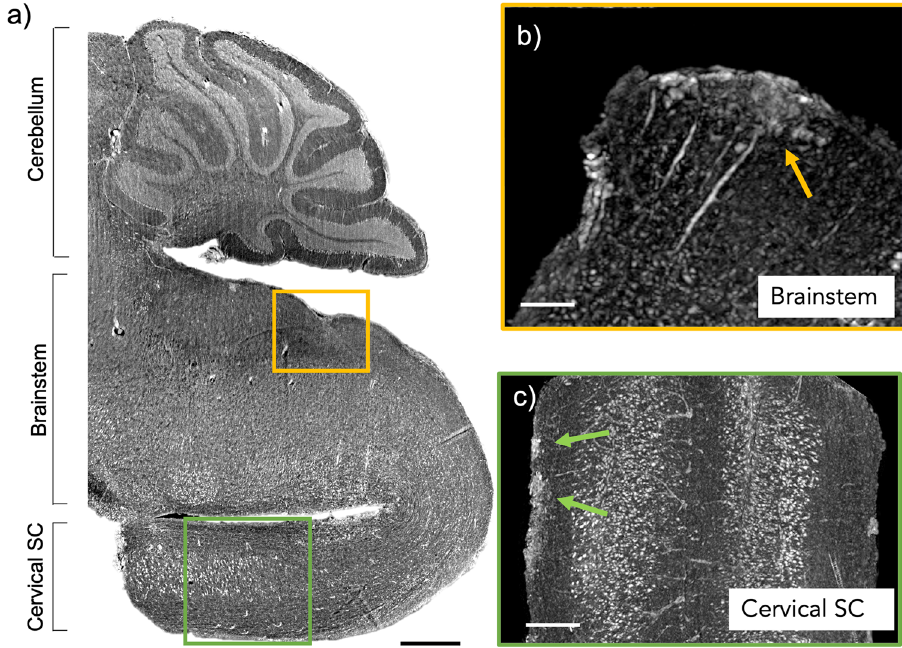
Fig. 3 Vascular damage in brain and cervical spinal cord at clinical onset. X-ray phase contrast tomography (XPCT) shows vascular damage in experimental autoimmune encephalomyelitis (EAE) brain and cervical spinal cord at clinical onset. a XPCT image showing a representative sagittal view of cerebellum, brain stem, and cervical spinal cord of an EAE-induced mouse at disease onset. The yellow and green squares indicate respectively where the lesions showed in ( b ) and ( c ) are located. Scale bar = 500 μ m. b XPCT image of a detail of the brainstem at EAE onset, with the presence of clouds (indicated by the yellow arrow) at the base of the vessels (scale bar = 50 μ m). c XPCT image showing coronal view of the cervical spinal cord of an EAE- induced mouse at onset. Green arrows highlight the vascular lesions (scale bar = 150 μ m). Clinical EAE score at the onset = 1.5. Images were obtained as maximum intensity projections of XPCT volumes ( a over 150 μ m; b over 80 μ m; c over 100 μ m). XPCT images were acquired in Experiment 3, reported in Methods.